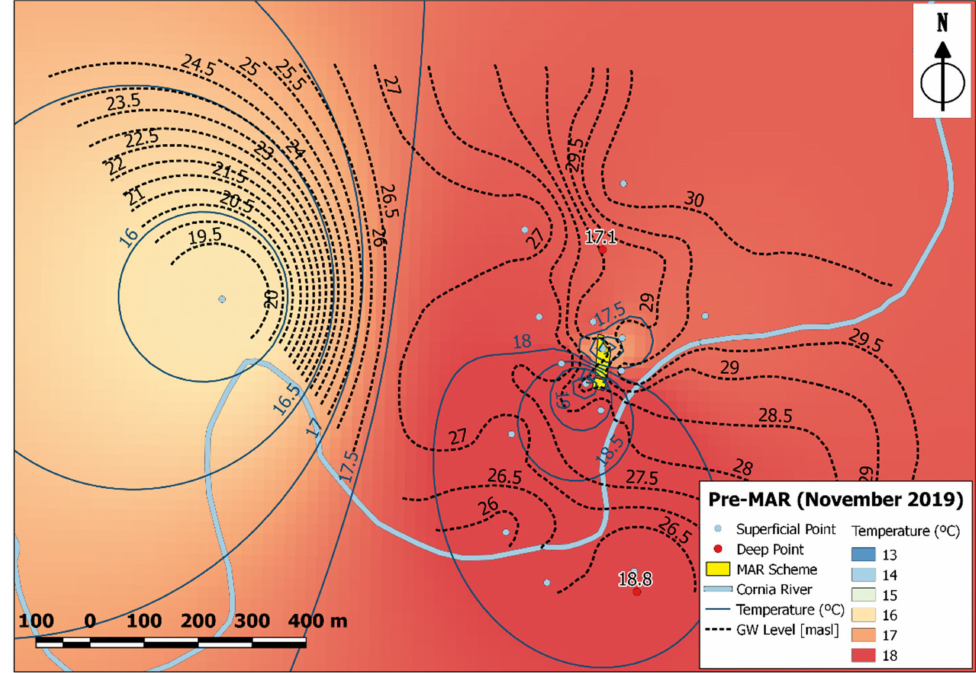
Figure 3. Groundwater temperature distribution in the aquifer before MAR operations started. Data taken from 25 November 2019 to 27 November